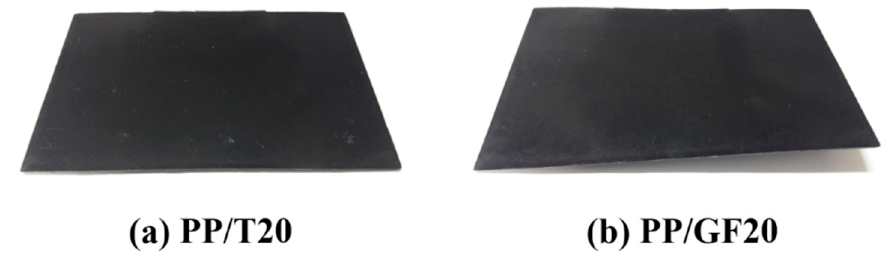
Figure 8. Warpage of test samples: ( a ) PP/T20 and ( b ) PP/GF20.